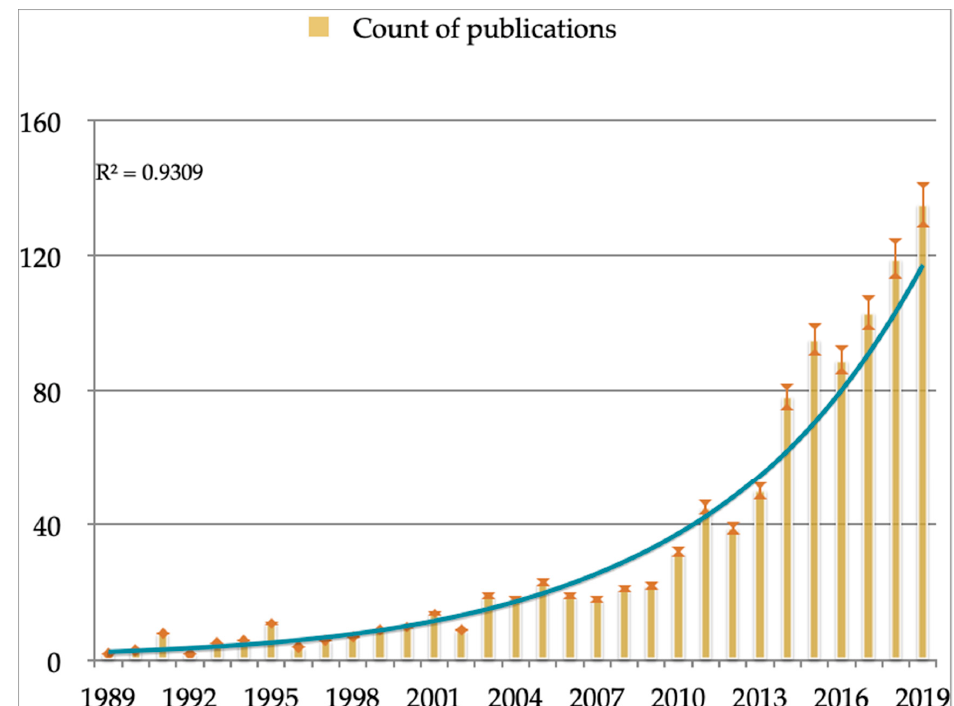
Figure 2. Number of papers per year and exponential trendlines. Note: the error bars and exponential trendline are based on percentage and count of publications. Table 2. Number of papers and citations per country from the